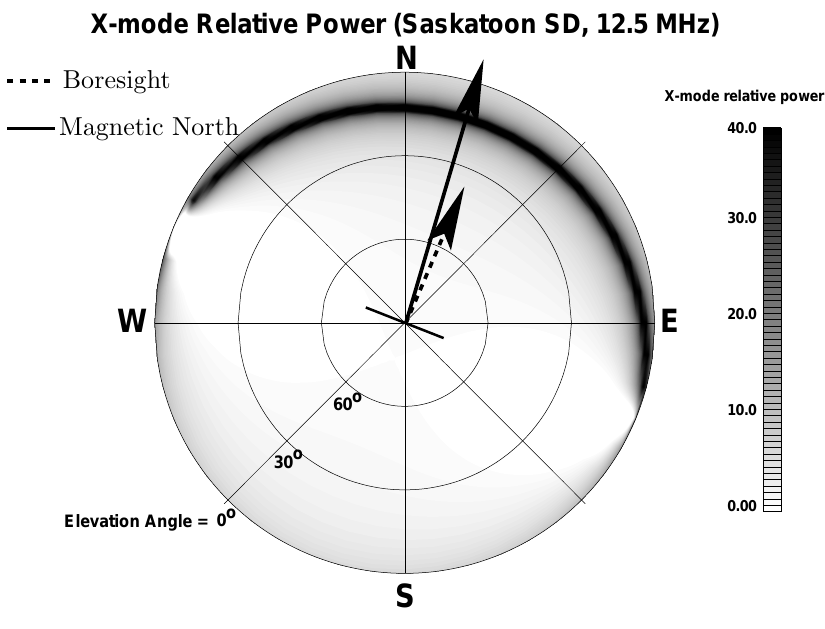
Fig. 3. Relative power delivered to the X-mode (Eq. 26) at 12.5MHz from the Saskatoon SuperDARN as a function of elevation and azimuth angles. Table 1. Locations of Canadian SuperDARN radars.